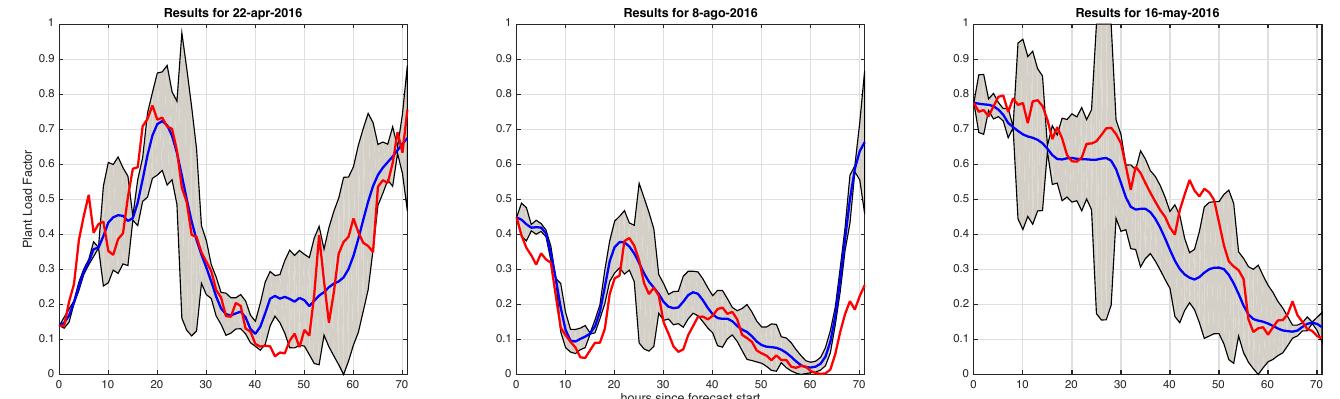
Figure 9. Wind-energy bands for three random days within Meteológica’s training set [ λ = 1, θ = 0.05]. The x-axis represents the number of hours ahead for each forecast, while the y-axis corresponds to the PLF. Blue curves are associated with power forecasts while red ones are the actual values. Finally, the grey area represents the wind-power band for θ = 0.05 and λ = 1. Since λ equals 1, every day within the training set must be effectively included; that is, y d = 1 for each d ∈ D , so all days are treated as regular. Furthermore, when λ = 1 then (2) turns out to be a pure linear programing problem, and running times are